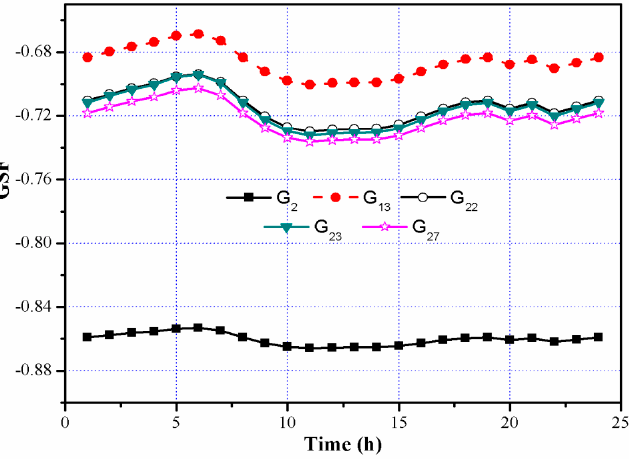
Figure 4. GSF without joint WF and PHS system for modified IEEE 30 bus system.